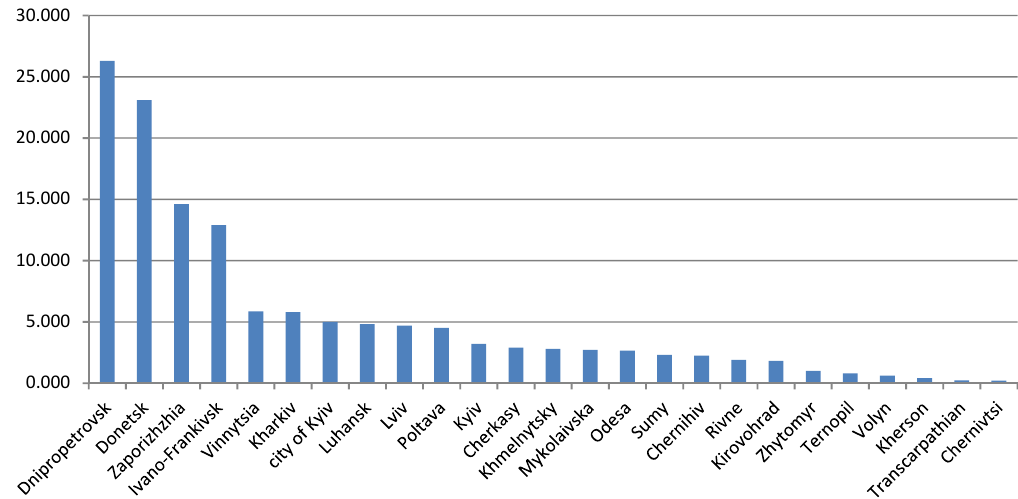
Figure 1. The impact of anthropogenic factor CO 2 emissions in the regions of Ukraine in 2021 [33].